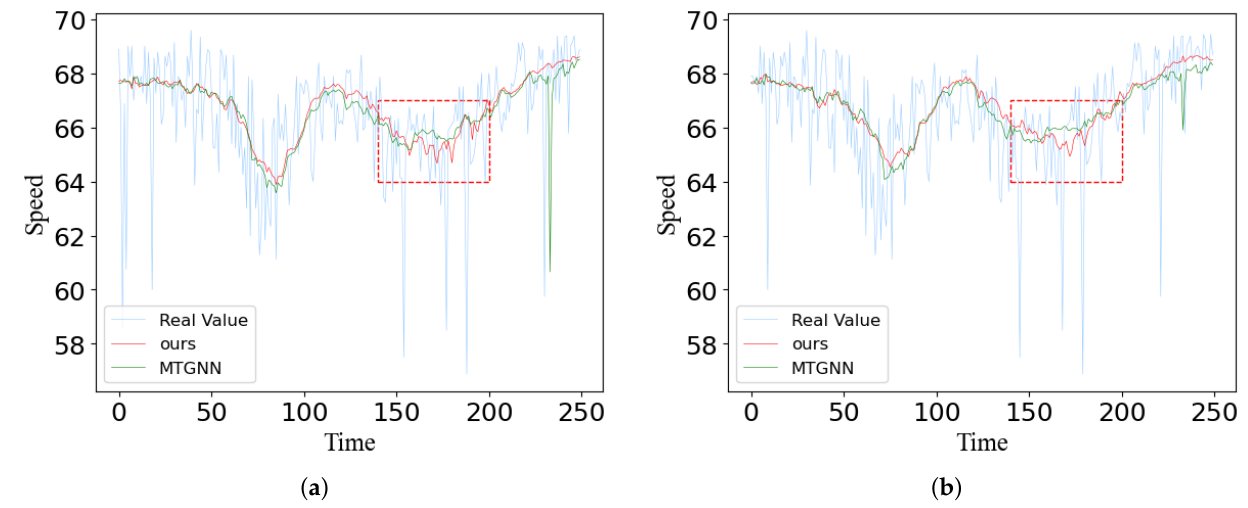
Figure 12. Traffic speed case study of two different stations on the METR-LA dataset: ( a ) sensor 1;